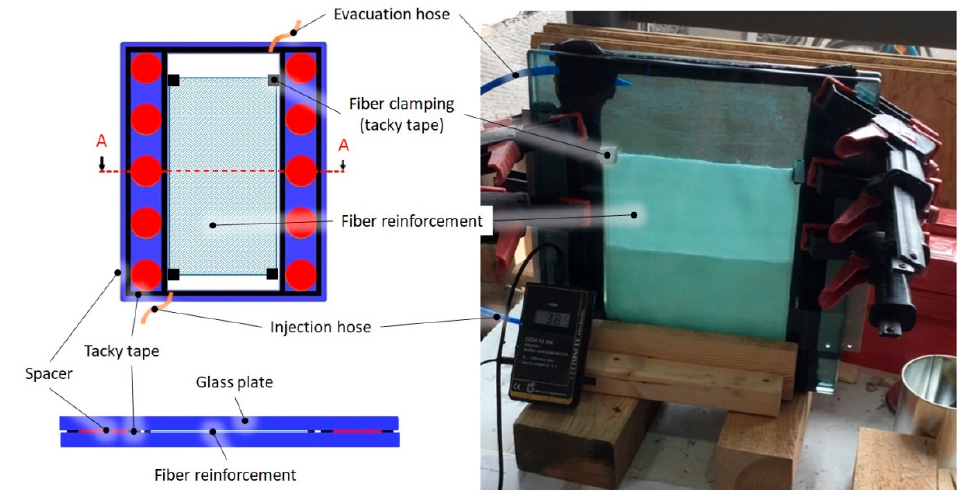
Figure 3. The L-RTM setup for manufacturing of the transparent specimens (tGFRP).